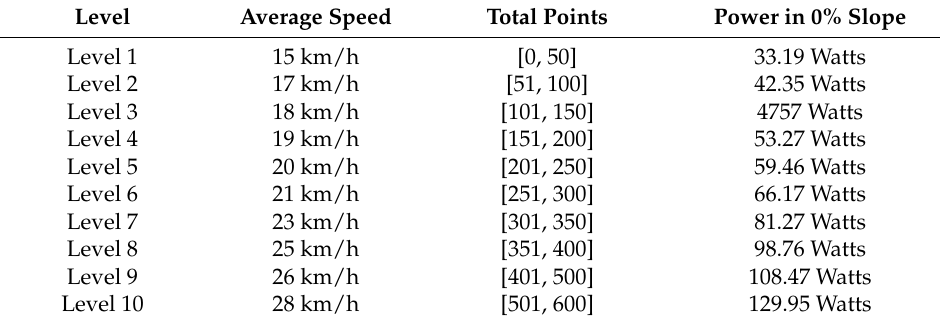
Table 2. Ability levels, average speed and the score required for each